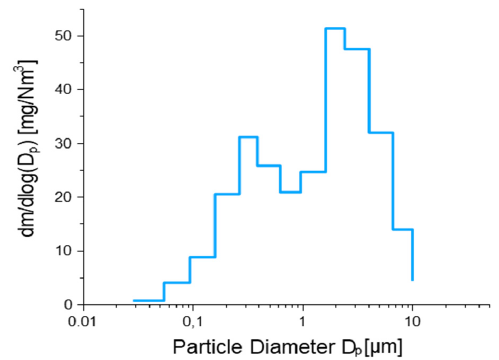
Figure 3. Size distribution of PM mass [mg/Nm 3 ] over the 13 size fractions.